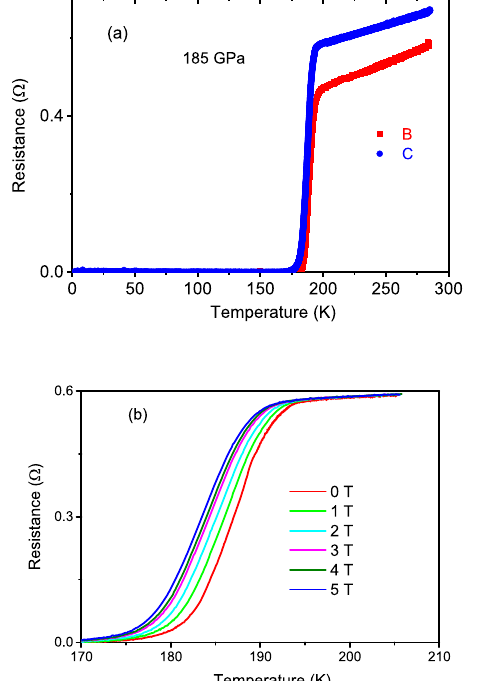
Fig. 3 Evolution of superconducting transitions as functions of magnetic fi elds. a The temperature dependence of resistance measured for Samples B and C at 185 GPa showing one-step transition; b Resistance curves measured under different magnetic fi eld for Sample C.